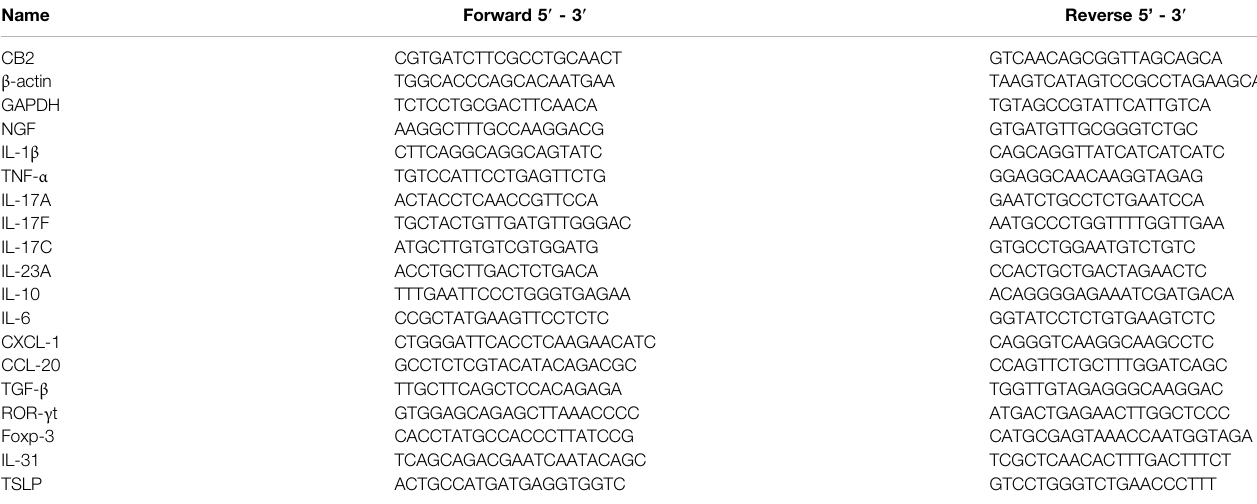
TABLE 1 | Primer sequences for real-time quantitative